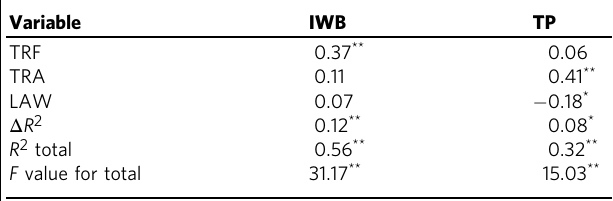
Table 6 Regression results in impacts of leadership styles on innovative work behavior and task performance while controlling work